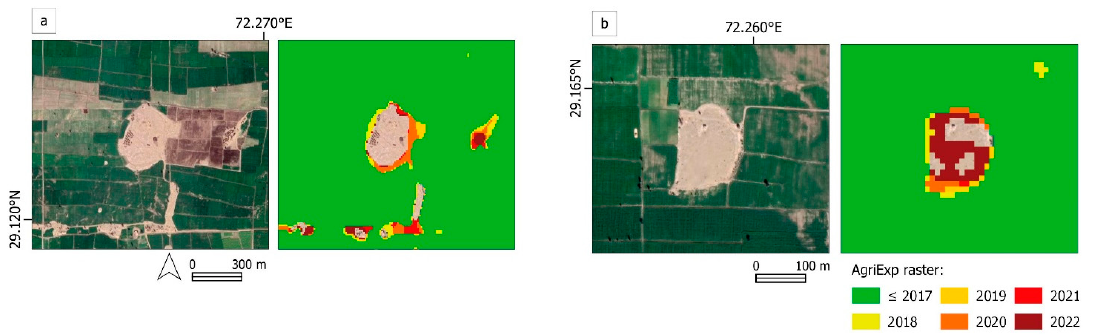
Figure 11. ( a , b ) Newly detected potential mound surfaces in areas with long-term agricultural activities. Note that the surface of mound ( b ) has been encroached and severely impacted throughout 2022.